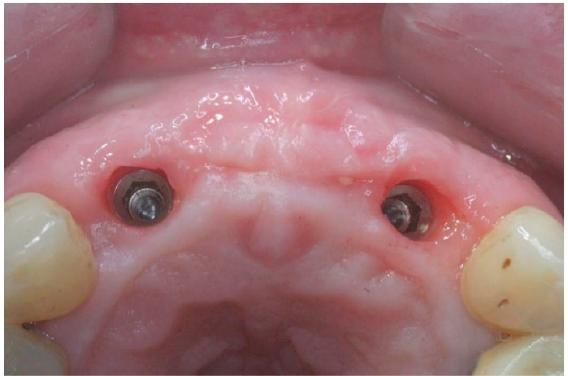
Figure 7. Occlusal view of healthy augmented soft tissue with keratinized sulcular epithelium six months after implant placement and immediate restoration (an FDBA exfoliated graft particle mesial to the left implant is shown) (patient #29).